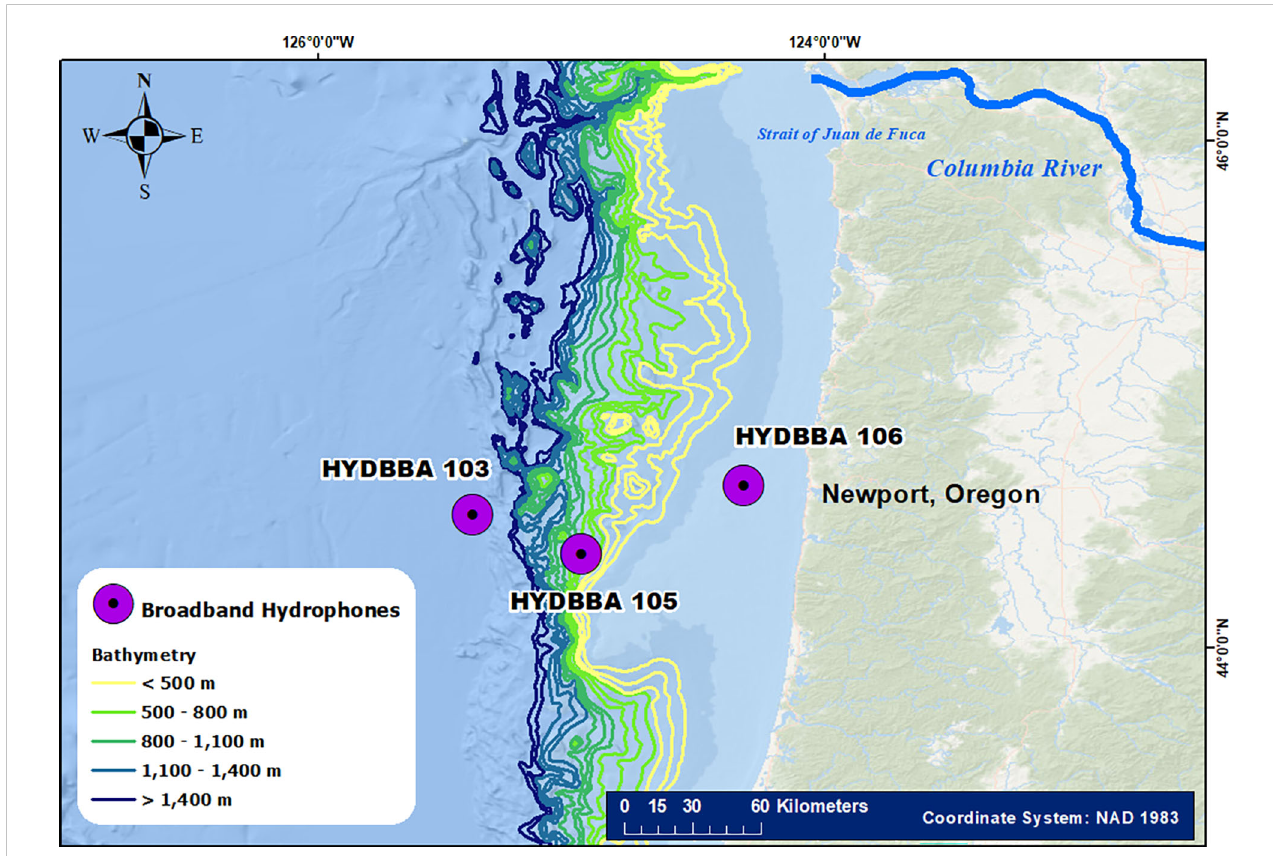
FIGURE 1 Map of the study area showing the location of the three recorders on the Ocean Observatories Initiative cabled arrays. The recorders on the shelf at 80 m (HYDBBA 106) and the slope at ~580 m (HYDBBA 105) are part of the Coastal Endurance array. The recorder on the base of the slope on a 200 m shallow pro fi ler mooring (HYDBBA 103) is part of the Cabled Continental Marin array. Recorders are located 30 km to 60 km from each other and offshore from Newport, Oregon. Bathymetric lines indicate increasing depth across the slope with darker